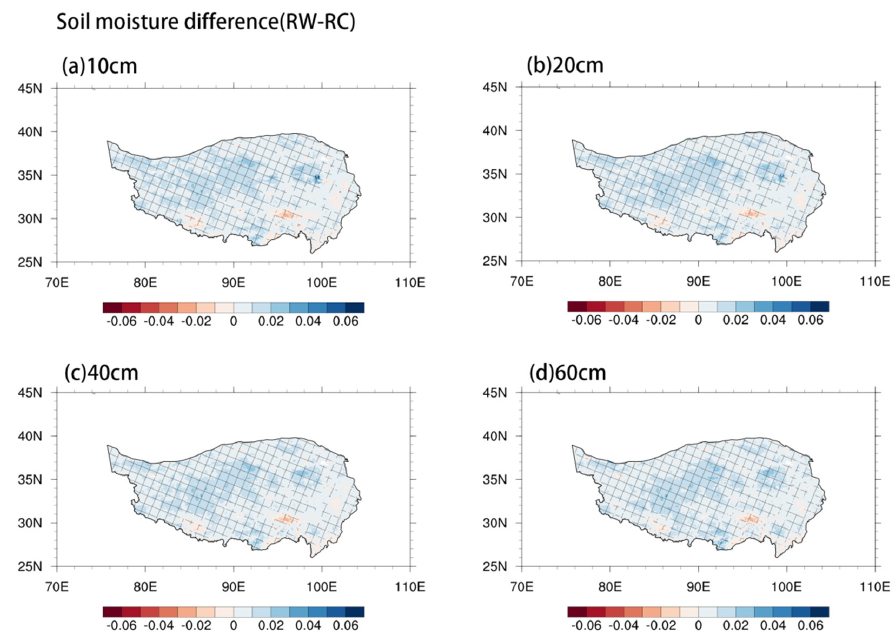
Figure 8. Same as Figure 7, but for soil moisture (unit: m 3 /m 3 ).